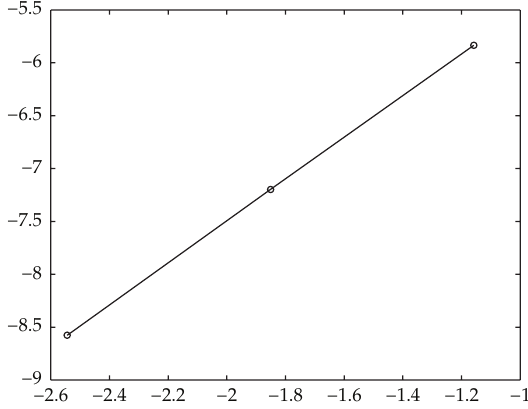
Figure 6: Approximation order of C in L 2 norm, Example